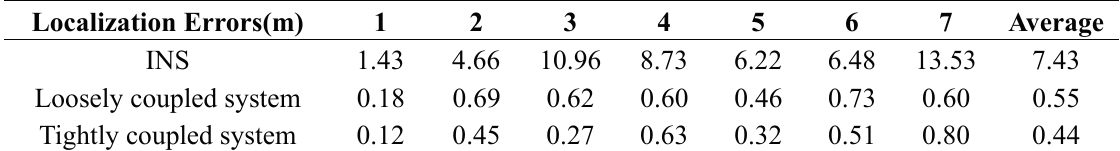
Table 3. Position